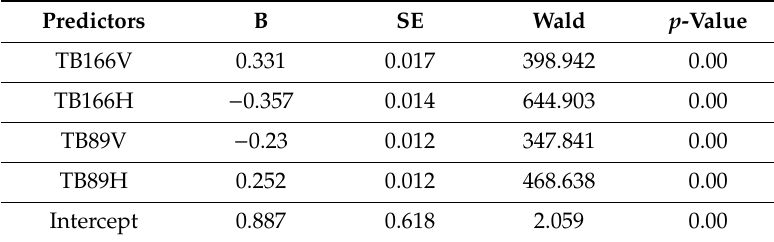
Table 4. Logistic regression model coe ffi cients and statistics for single channel brightness temperature measurements, vertical and horizontal polarization, at 166 GHz (TB166 V and TB166H) and 89 GHz (TB89V and TB89H) as predictors. “B” indicates the partial regression coe ffi cients, “SE” indicates the standard error, and “Wald” indicates the observed Wald test